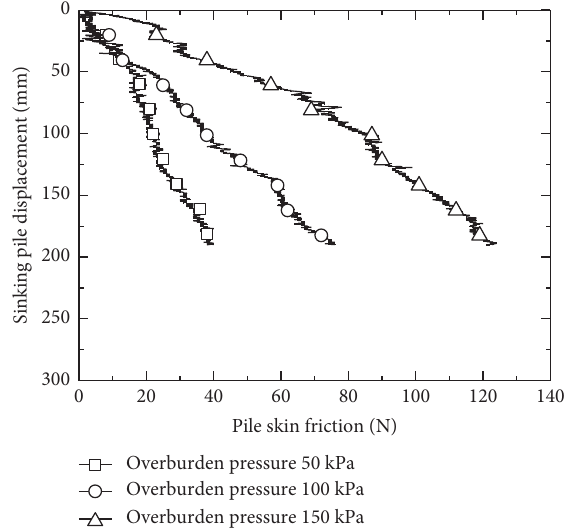
Figure 11: Relation curves for pile skin friction-pile sinking